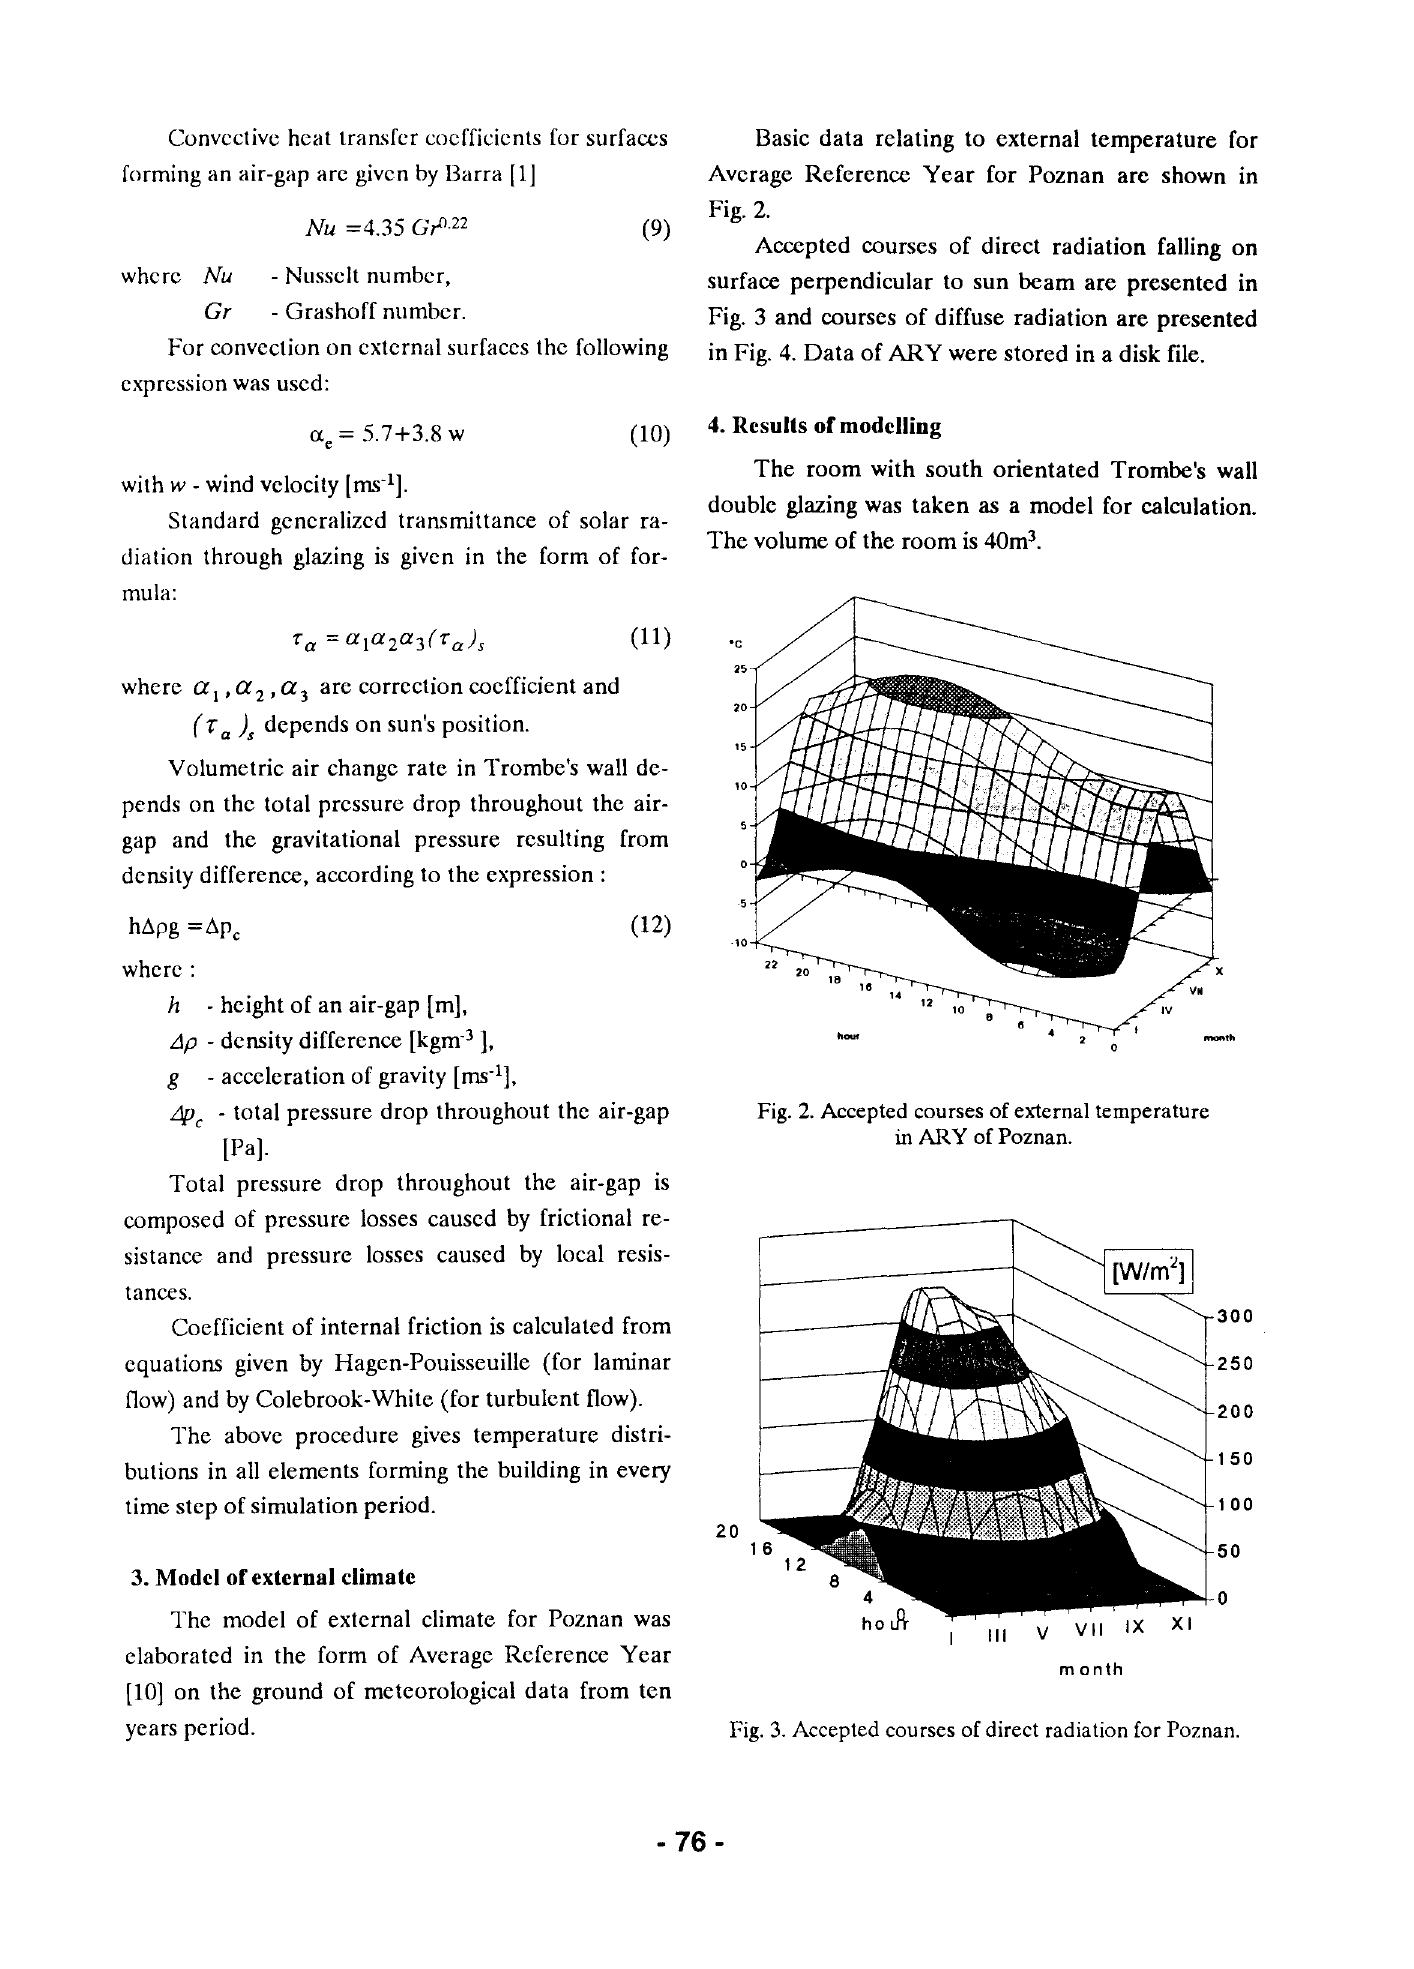
Fig. 3. Accepted courses of direct radiation for Poznan